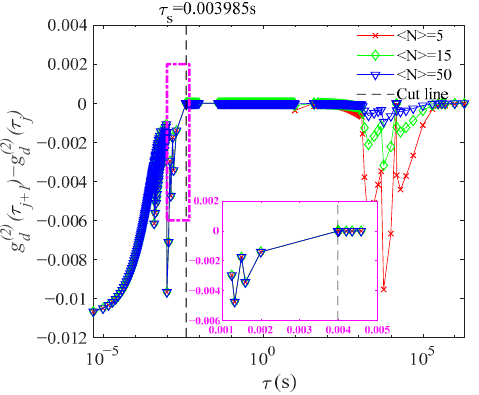
(cid:16) (cid:17) (cid:16) (cid:17) ( 2 ) ( 2 ) τ j + 1 τ j and g . d d